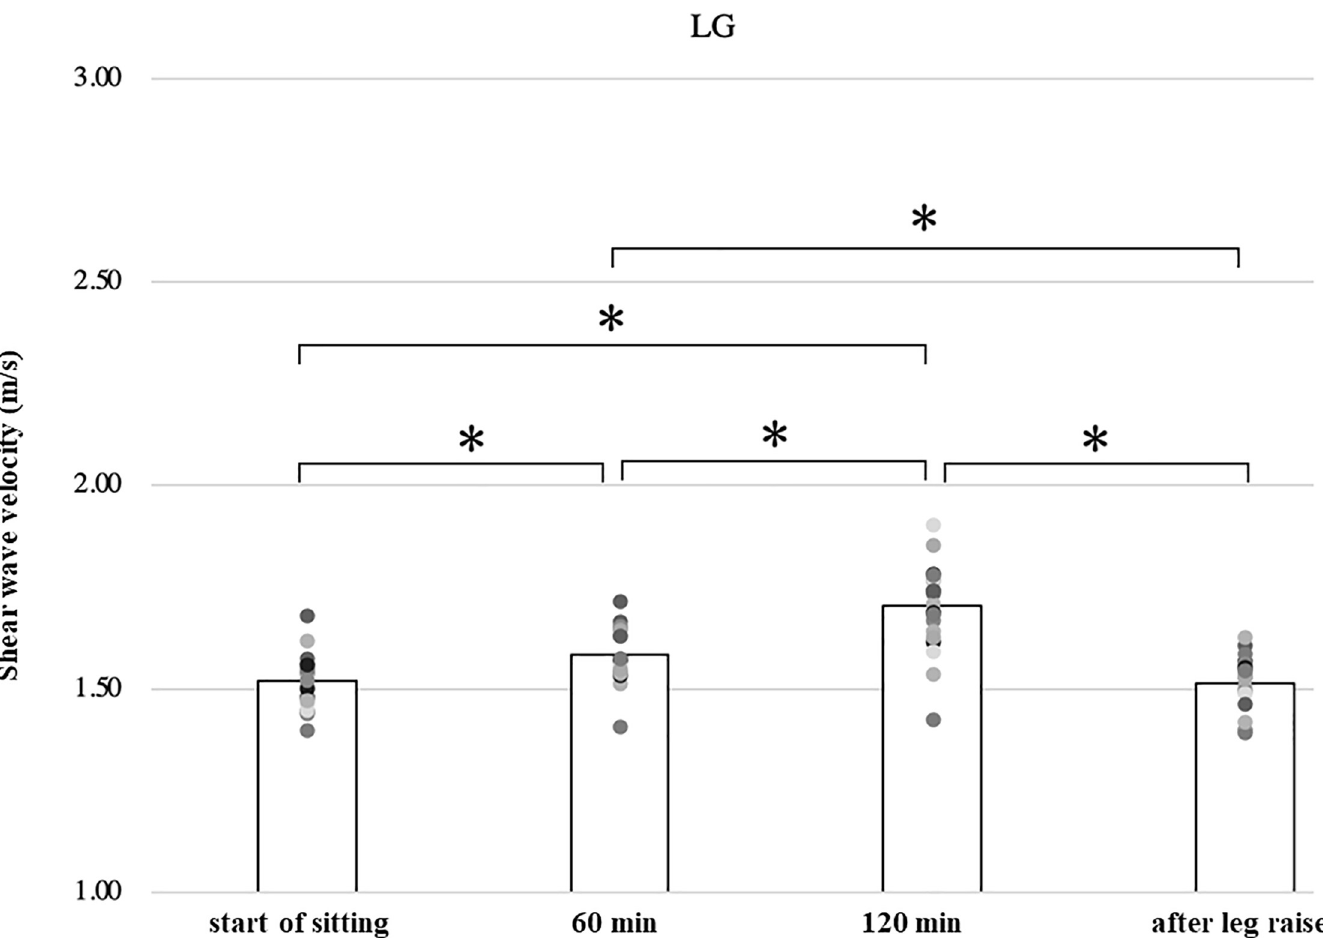
Fig 5. Shear wave velocity of the lateral gastrocnemius.